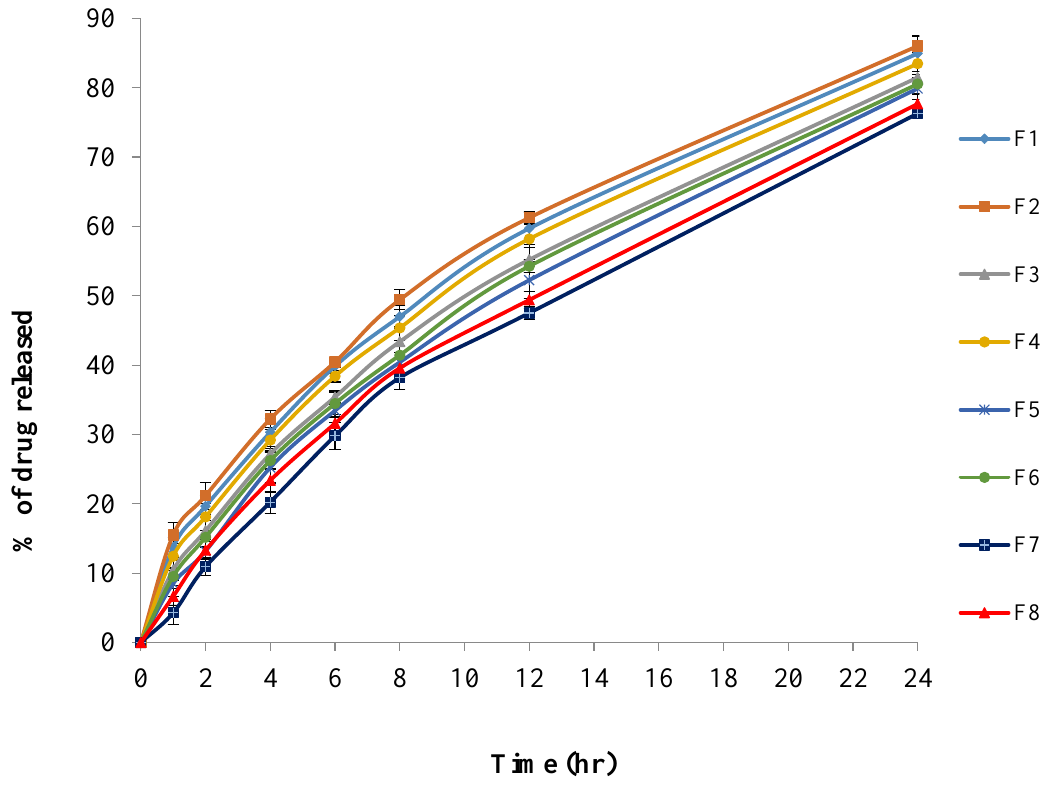
Figure 3. In vitro release profile of MIC from the prepared Transfersomes